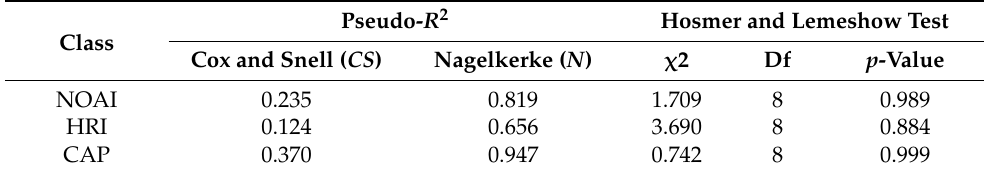
Table 5. The model summary and evaluation result.